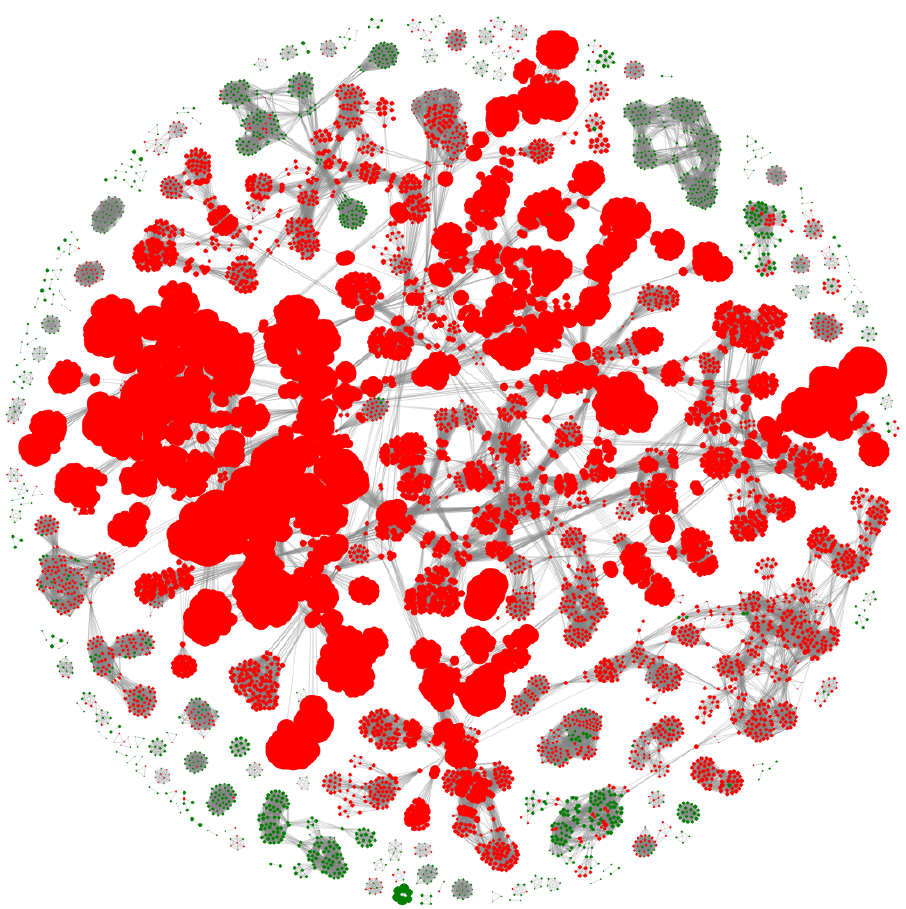
Figure 1. Network graph of the integrase dataset with green dots indicating positive labels and red dots indicating negative labels.